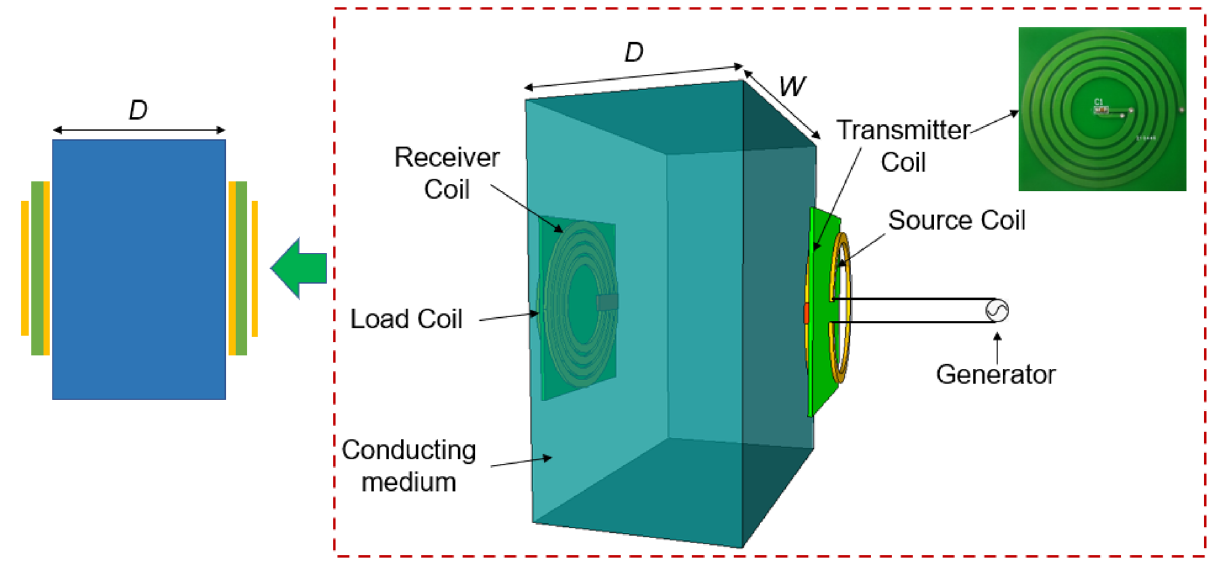
Figure 1. Schematic of MR-WPT system with a conducting block in the between Tx and